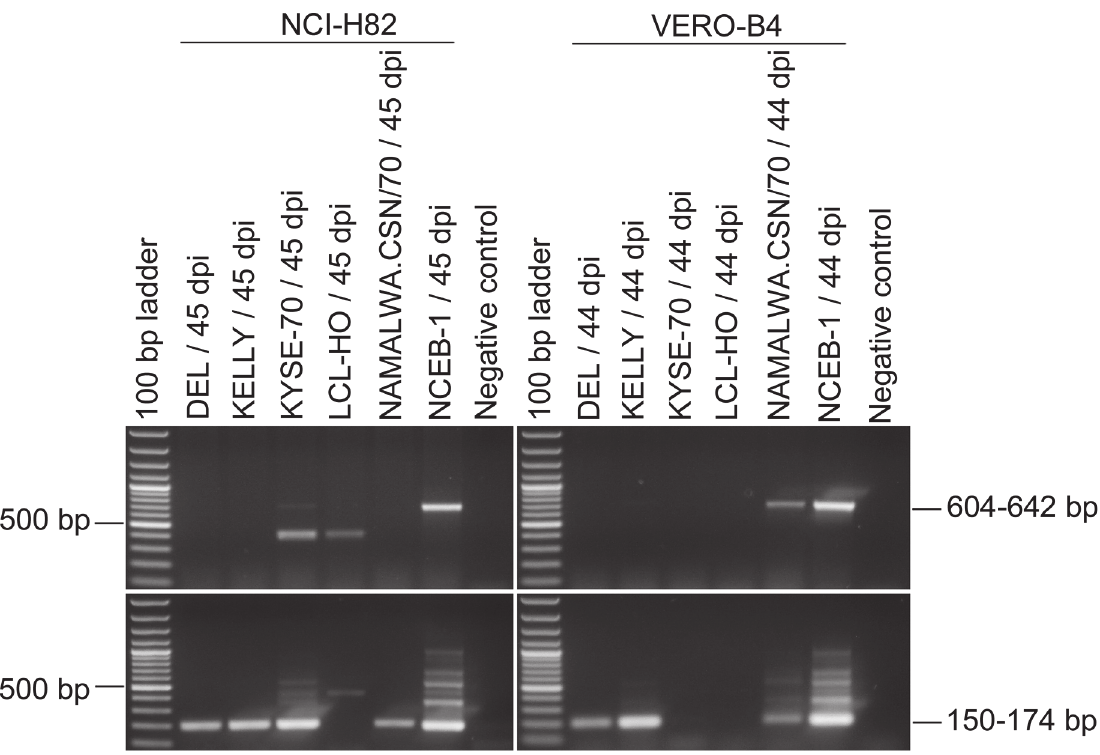
Fig 8. PCR-Assays for the detection of MLV sequences in cell lines infected with MLV from contaminated cell lines. The cell lines NCI-H82 and VERO-B4 were infected with cell culture supernatant of the cell lines DEL, KELLY, KYSE-70, LCL-HO, NAMALWA.CSN/70, or NCEB-1. DNA of the infected cell lines was prepared after 44 or 45 days (dpi, days post infection). NCI-H82 and VERO-B4 were previously shown to be MLV-negative. Only the 604 – 642 bp bands and the 150 – 174 bp bands are specific for MLV contaminations determined by the outer and inner primers, respectively.